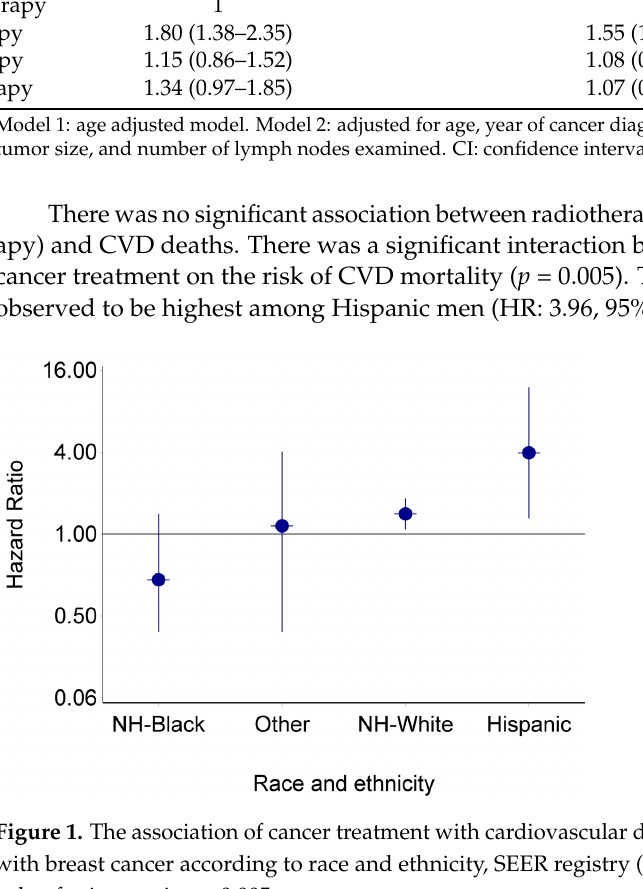
Figure 1. The association of cancer treatment with cardiovascular disease mortality in men diagnosed with breast cancer according to race and ethnicity, SEER registry (2000–2019). NH: Non-Hispanic. p value for interaction =